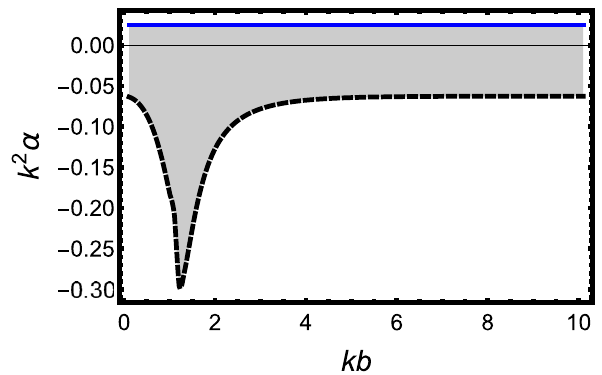
Fig. 6 The warp factor and the energy density of model 3. The param- eter v is set to v = 1. In the left panel we set kb = 1 for the black line, kb = 3 for the thick blue line, and kb = 5 for the dashed red line. In the right panel we set kb = 5 and k 2 α = − 0 . 06 for the black line, k 2 α = − 0 . 03 for the thick blue line, and k 2 α = 0 . 02 for the dashed red line